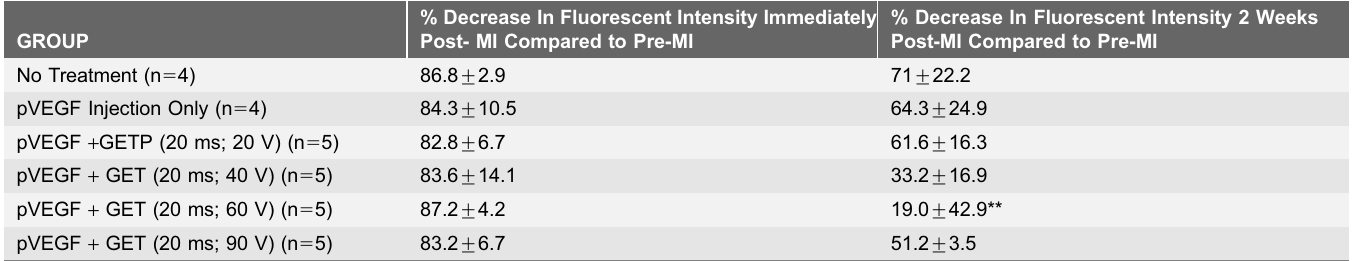
Table 1. Fluorescent Intensity measurement using The SPY Elite Intraoperative Perfusion Assessment System.